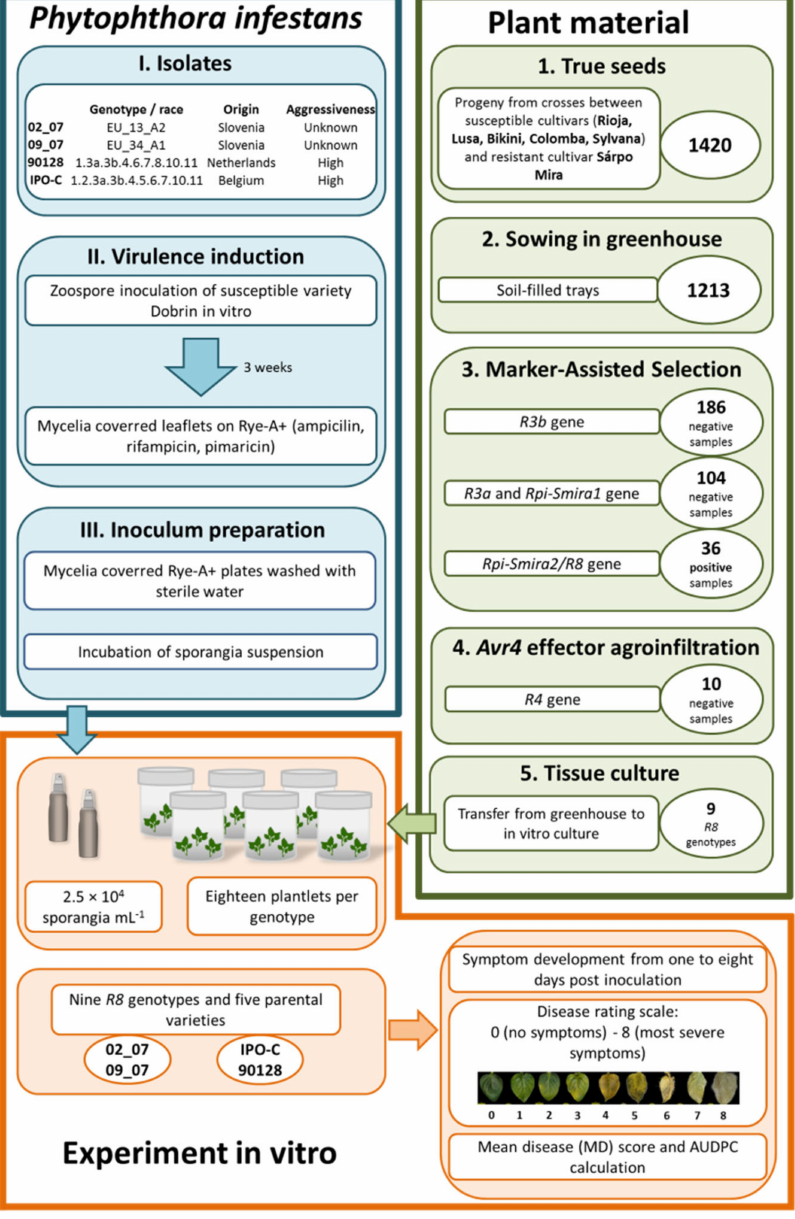
Figure 1. Diagram of Phytophthora infestans inoculum preparation, selection of R8 potato genotypes, and experimental design of P. infestans inoculation of R8 genotypes in